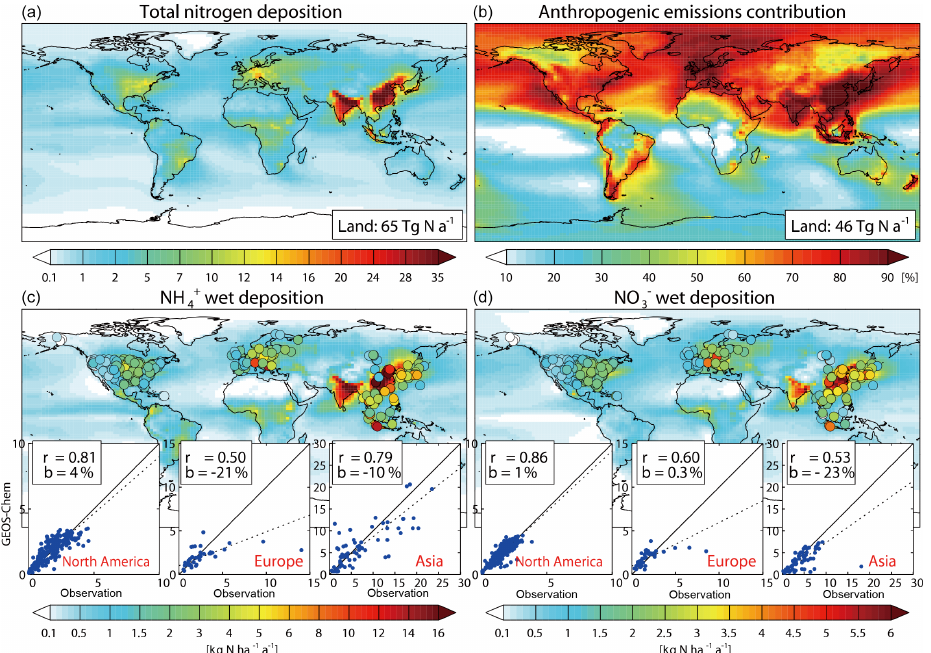
Figure 3. Top panels show total nitrogen deposition fluxes (left) and contributions from anthropogenic sources estimated as percentage changes in the GEOS-Chem simulation with all anthropogenic emissions turned off relative to the simulation with anthropogenic emissions turned on (right). Annual total deposition values to land are shown inset. Bottom panels compare the simulated NH + (right) wet deposition fluxes with an ensemble of surface measurements over North America, Europe, and Asia as described in the text. The comparison scatterplots are overplotted with correlation coefficients ( r ) and normalized mean biases ( b ) also shown